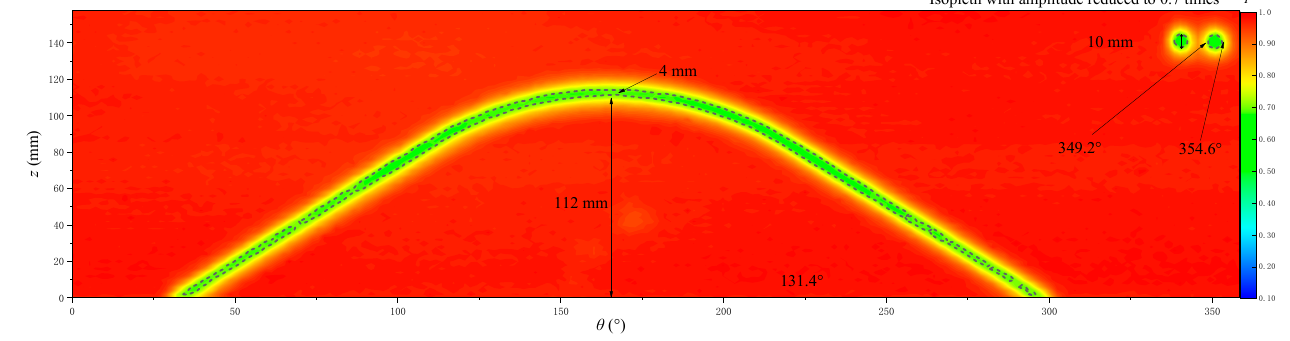
Figure 27. Echo amplitude imaging of oblique fractures and holes.